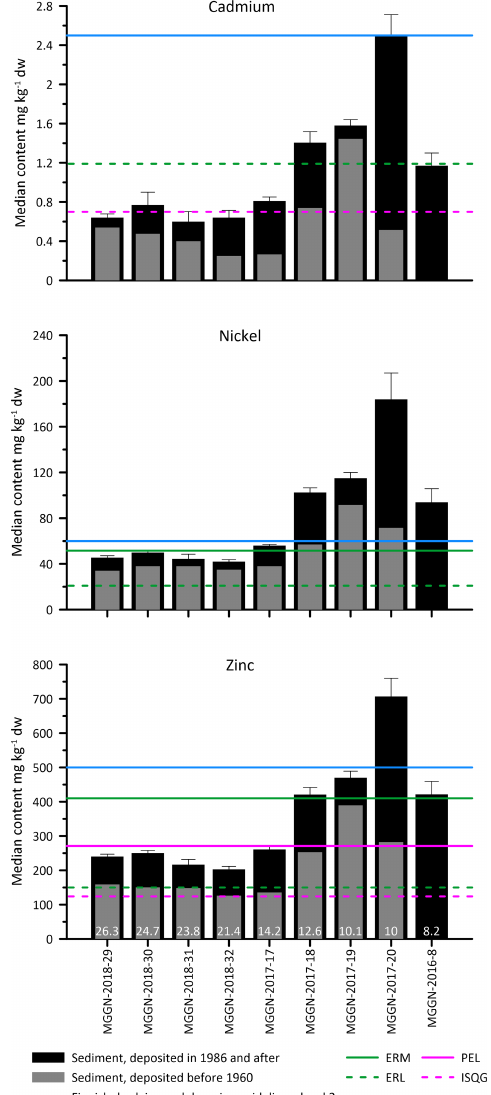
Figure 6. Median Cd, Ni, and Zn contents in sediment cores, ar- ranged according to distance from the Laihianjoki and Sulvan- joki rivers, with sediment quality guidelines indicated. Black bars show median contents in core sections deposited in 1986 and later, whereas the narrower grey bars show contents in core sections de- posited before 1960. Whiskers above the black bars indicate the upper quartile of the contents. Note that core MGGN-2016-8 does not contain sediments deposited before 1960. White numbers in the Zn panel denote the distance to the closest river mouth in kilo- metres. The blue line indicates the level 2 threshold in Finnish sediment dredging and dumping guidelines (Ympäristöministeriö, 2015). Green solid and dashed lines indicate the North American effects range medium (ERM) and effects range low (ERL) thresh- olds, respectively (Long et al., 1995). Purple solid and dashed lines indicate the Canadian probable effect level (PEL) and interim sed- iment quality guideline (ISQG) thresholds, respectively (Canadian Council of Ministers of the Environment,